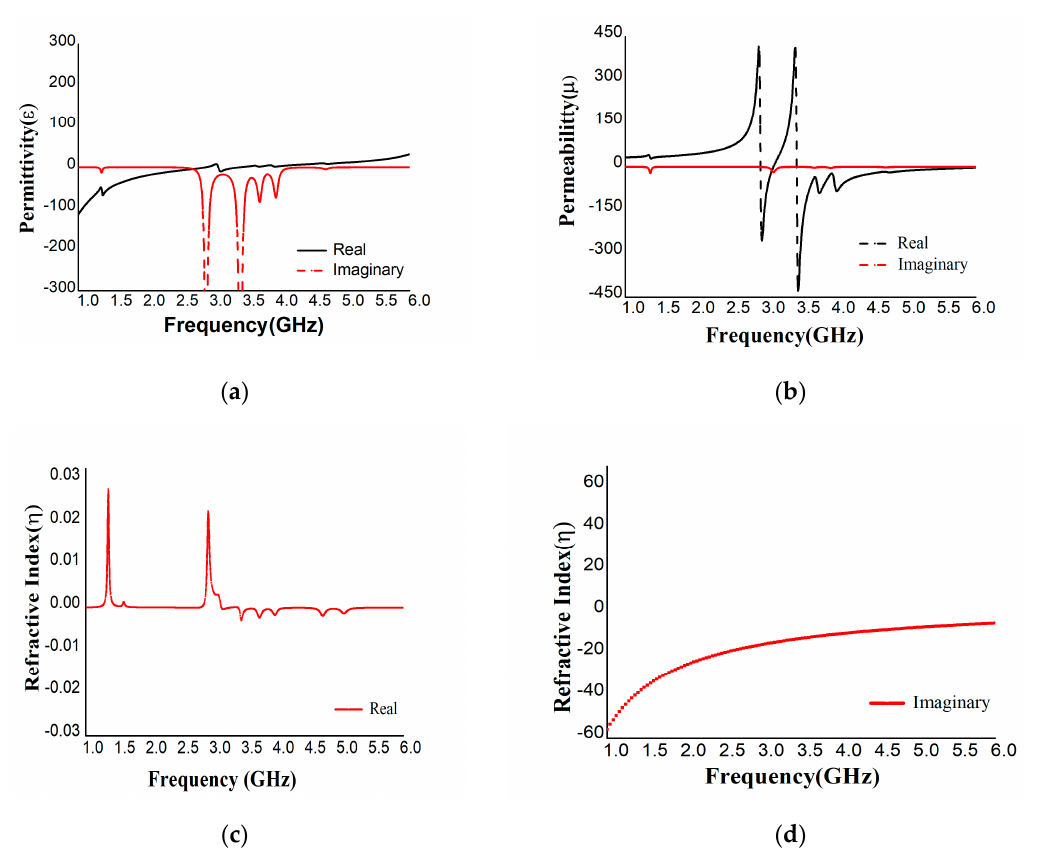
Figure 5. Real and Imaginary values of ( a ) permittivity, ( b ) permeability, and ( c , d ) reflective index for FR-4 substrate.